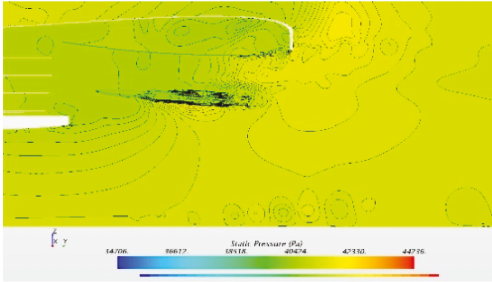
Figure 16: Flow fi eld pressure contour at 0.4s.